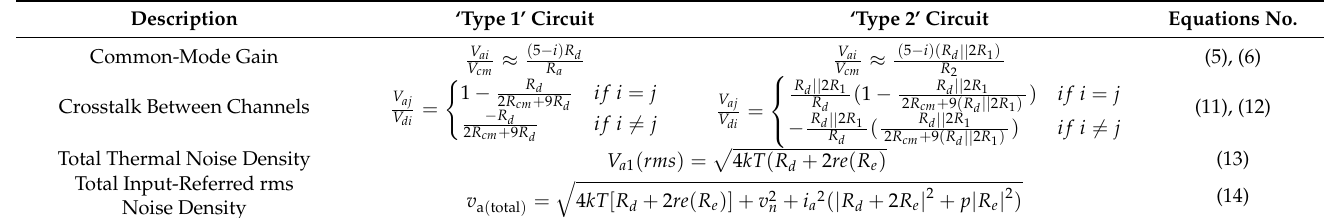
Table 2. Summary of the equations derived in this section (all R e , R a , R d are